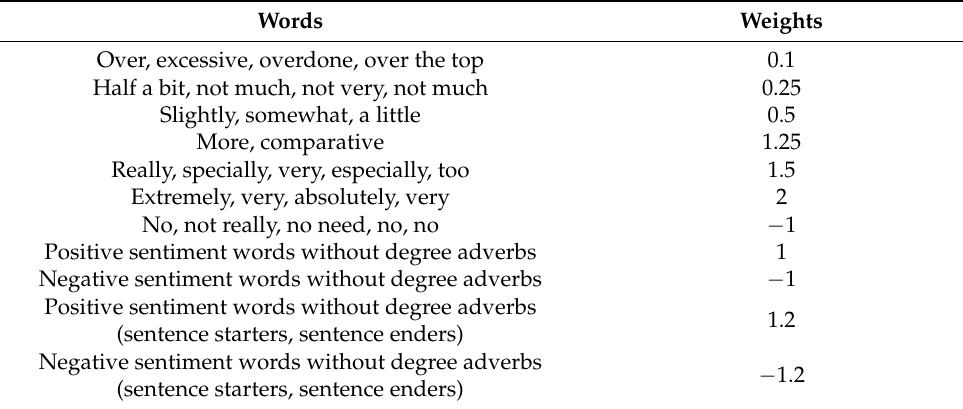
Table 5. Weights of various